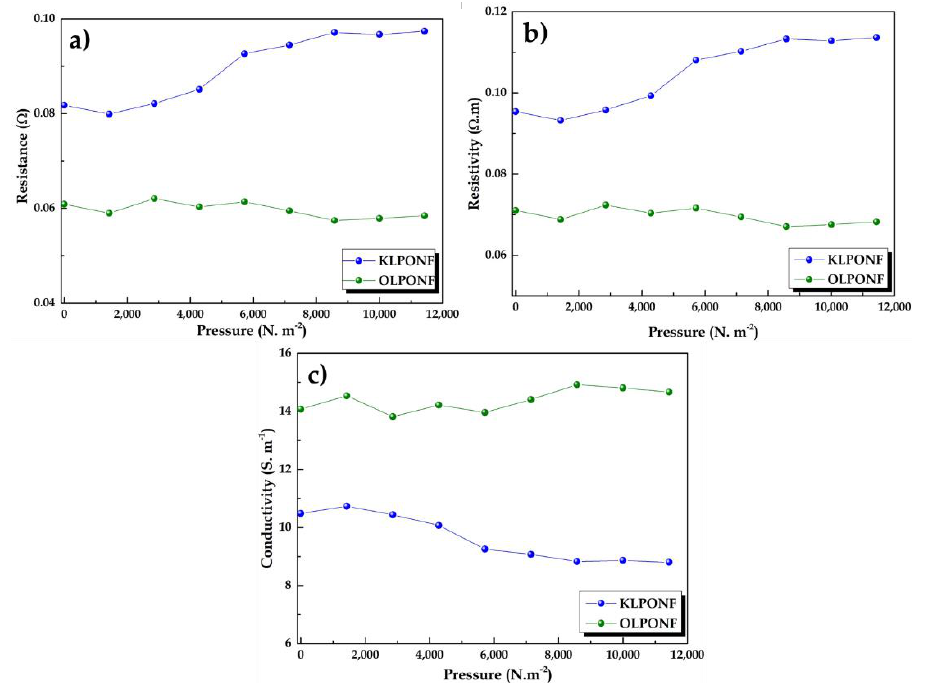
Figure 7. The variations of KLPONF and OLPONF membranes in terms of ( a ) resistance, ( b ) resistivity, and ( c ) conductivity with reference to applied pressure.